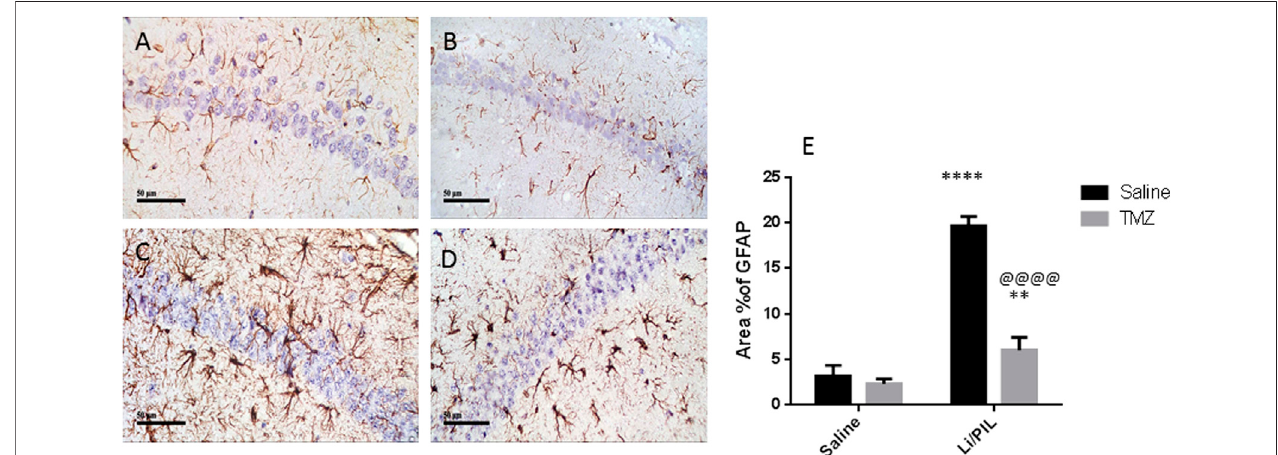
FIGURE 3 | Effect of TMZ on GFAP expression in the hippocampi of rats with Li/PIL-induced seizures as indicated by immunohistochemistry ( × 400 original magni fi cation). Normal control rats (A) , Normal + TMZ rats (B) , Li/PIL control rats (C) , and TMZ + Li/PIL rats (D) . Area % of GFAP (E) . Values are expressed as mean of three animals ± SD. Two-way ANOVA followed by the Tukey – Kramer post-hoc test was used for statistical analyses of data. **Signi fi cantly different from the normal control group (Saline) at p < 0.01; ****Signi fi cantly different from the normal control group (Saline) at p < 0.0001; @@@@ Signi fi cantly different from the Li/PIL control group at p < 0.0001.